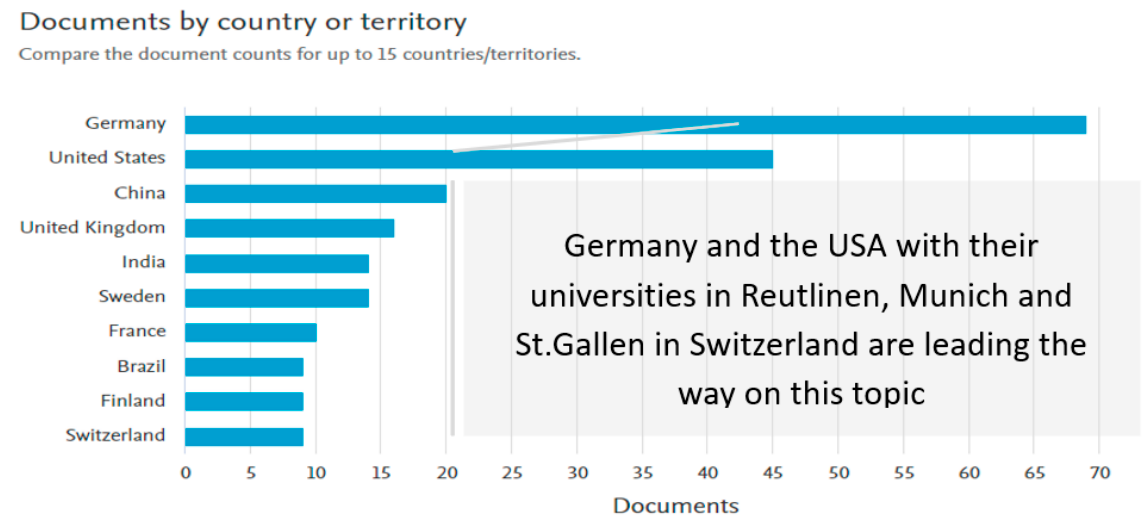
Figure 5. Agile AND transformation AND manufacturing—Documents by Country.